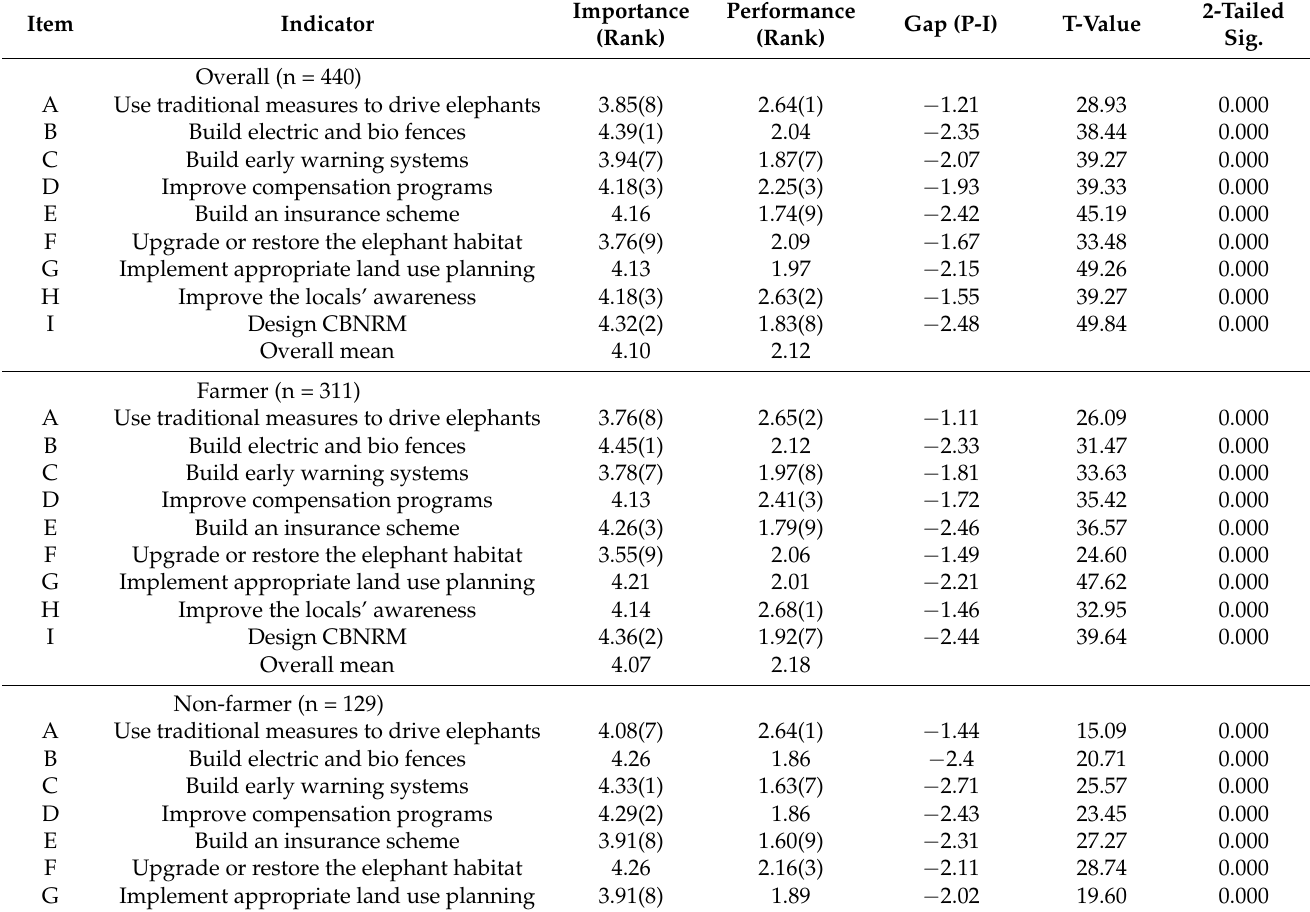
Table 3. Mean scores and PSTT among farmers and non-farmers for the HEC indicators on I-P